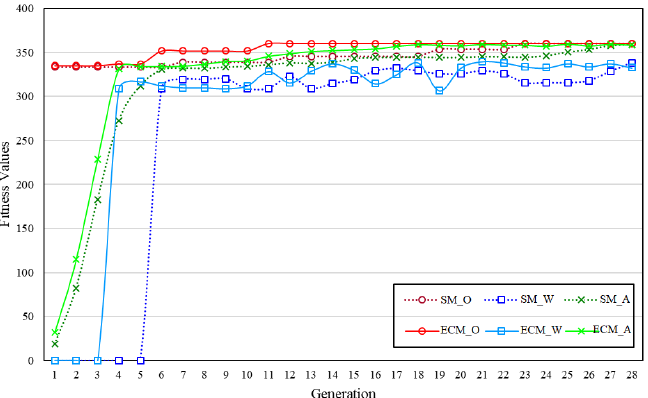
Figure 10. Compare of Traditional Mutation and Effectiveness-oriented